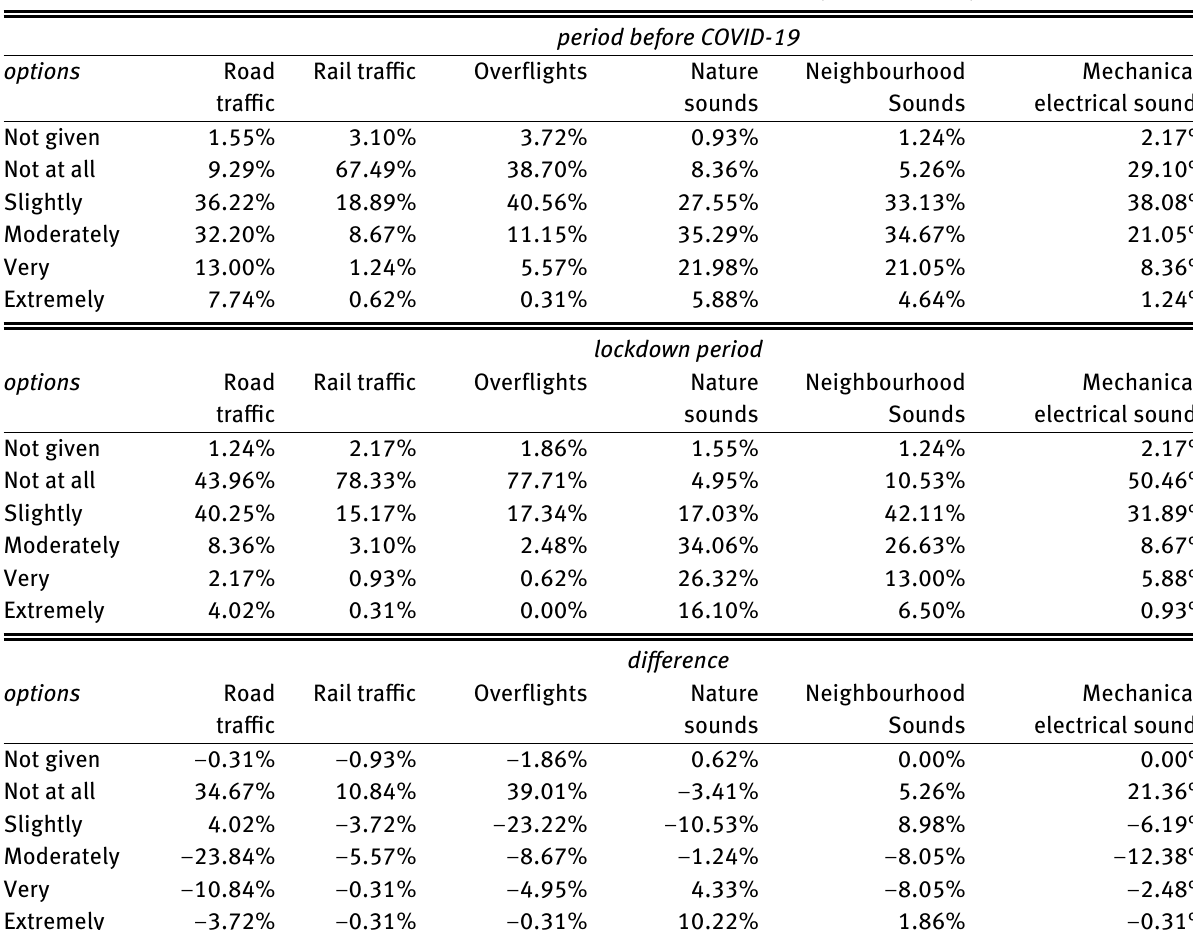
Table 11: Comparison between the lockdown period and the period before COVID-19 emergency regarding the type and the intensity of sounds coming from outside the house To what extent and what kind of sounds could/can you hear from your